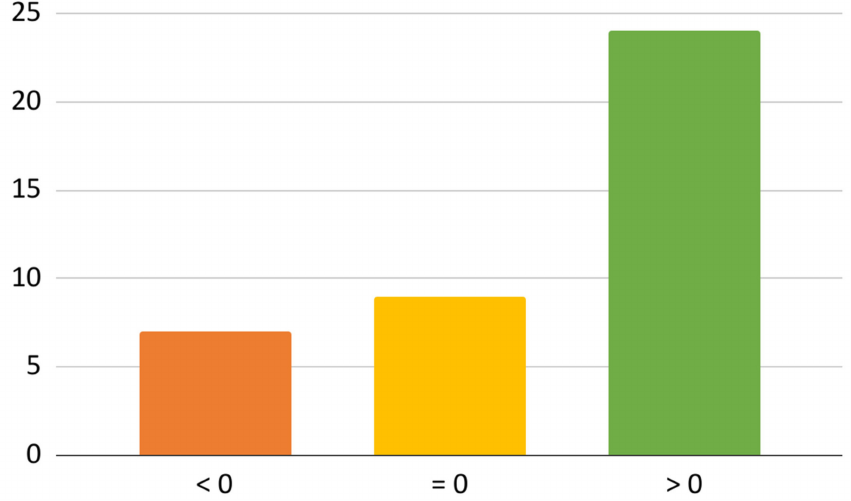
Figure A2. Number of patients who experienced mastication efficiency worsening (<0), mastication efficiency was unchanged (=0), and mastication efficiency was improved (>0) based on differences in VAS scores throughout the course of